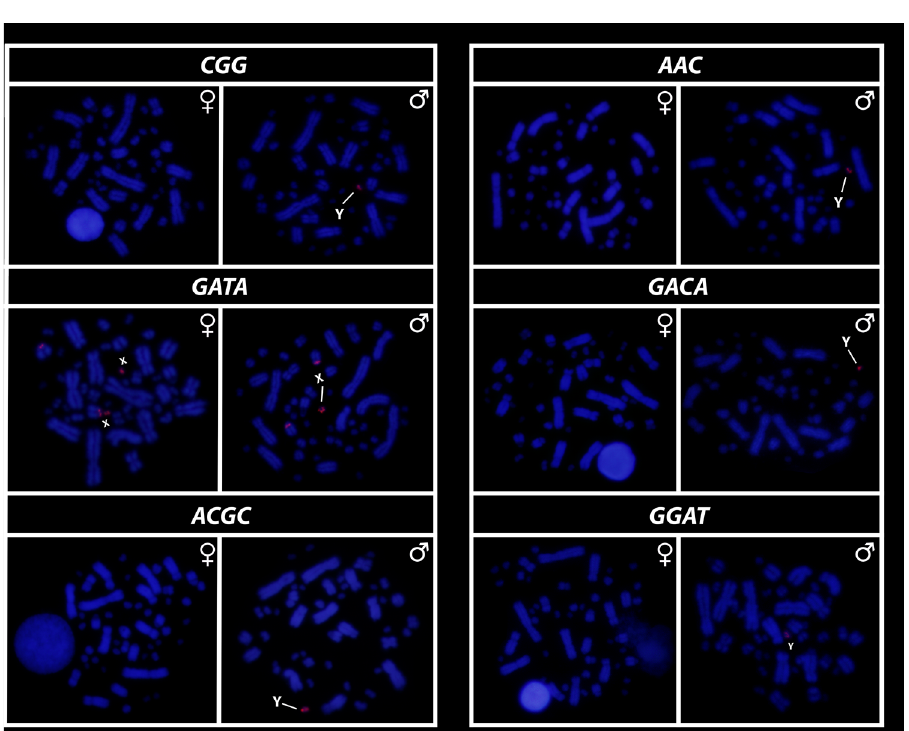
Figure 6. Mapping of tri and tetra-nucleotids on the chromosomes of males and females of Chelus orinocensis . Note the unique pattern of GATA motifs on X chromosomes (lines). The other SSRs showed only Y-specific accumulation